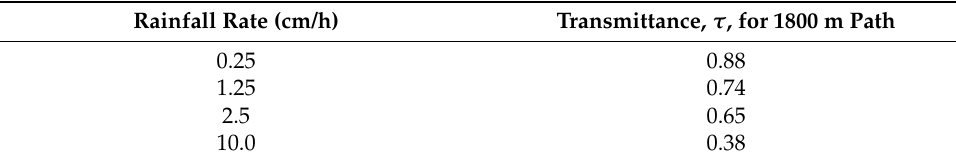
Table 6. Laser transmittance through rainfall [47].